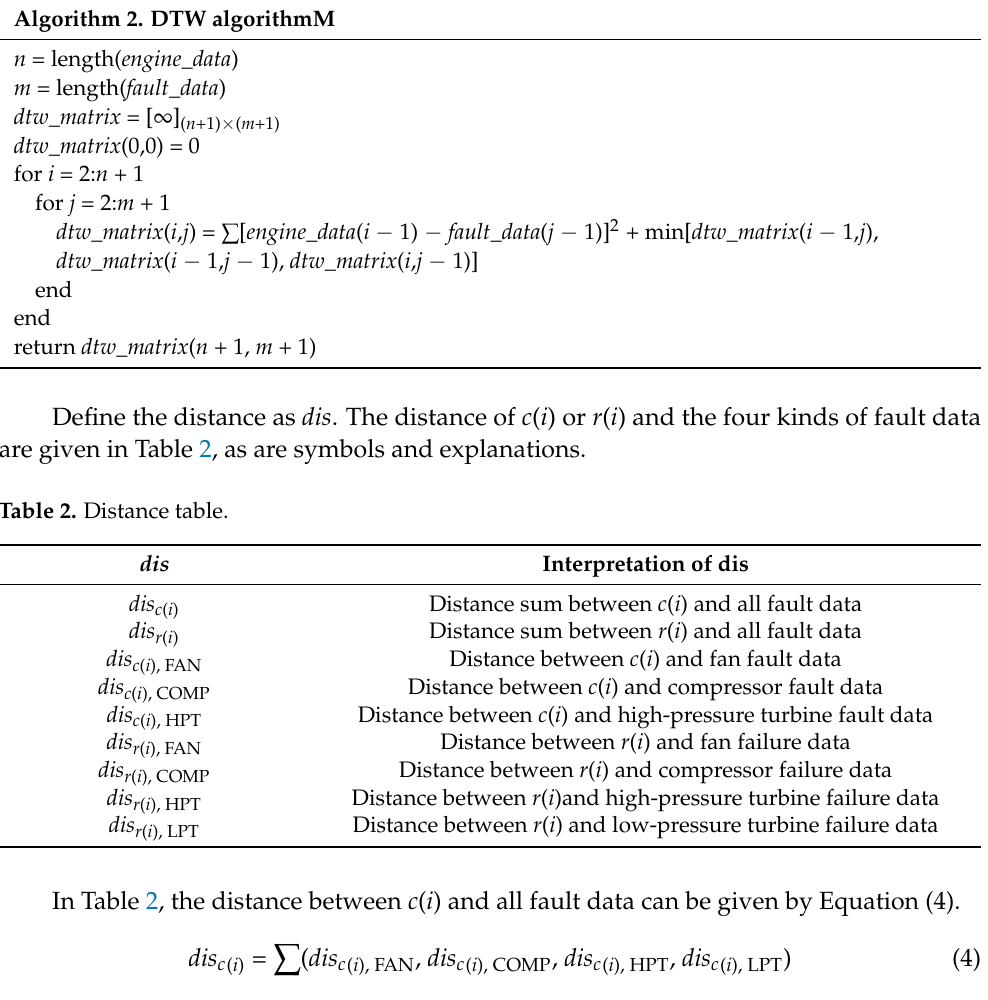
Algorithm 2. DTW Algorithm 2. DTW algorithm